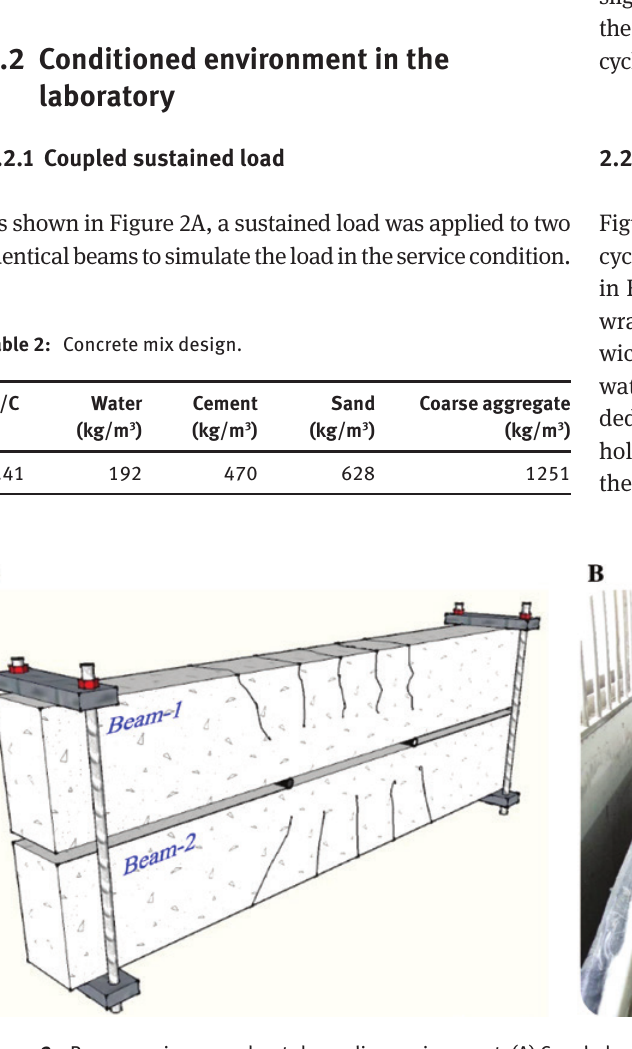
Figure 2: Beam specimens and wet-dry cycling environment. (A) Coupled sustained load and (B) Conditioned in